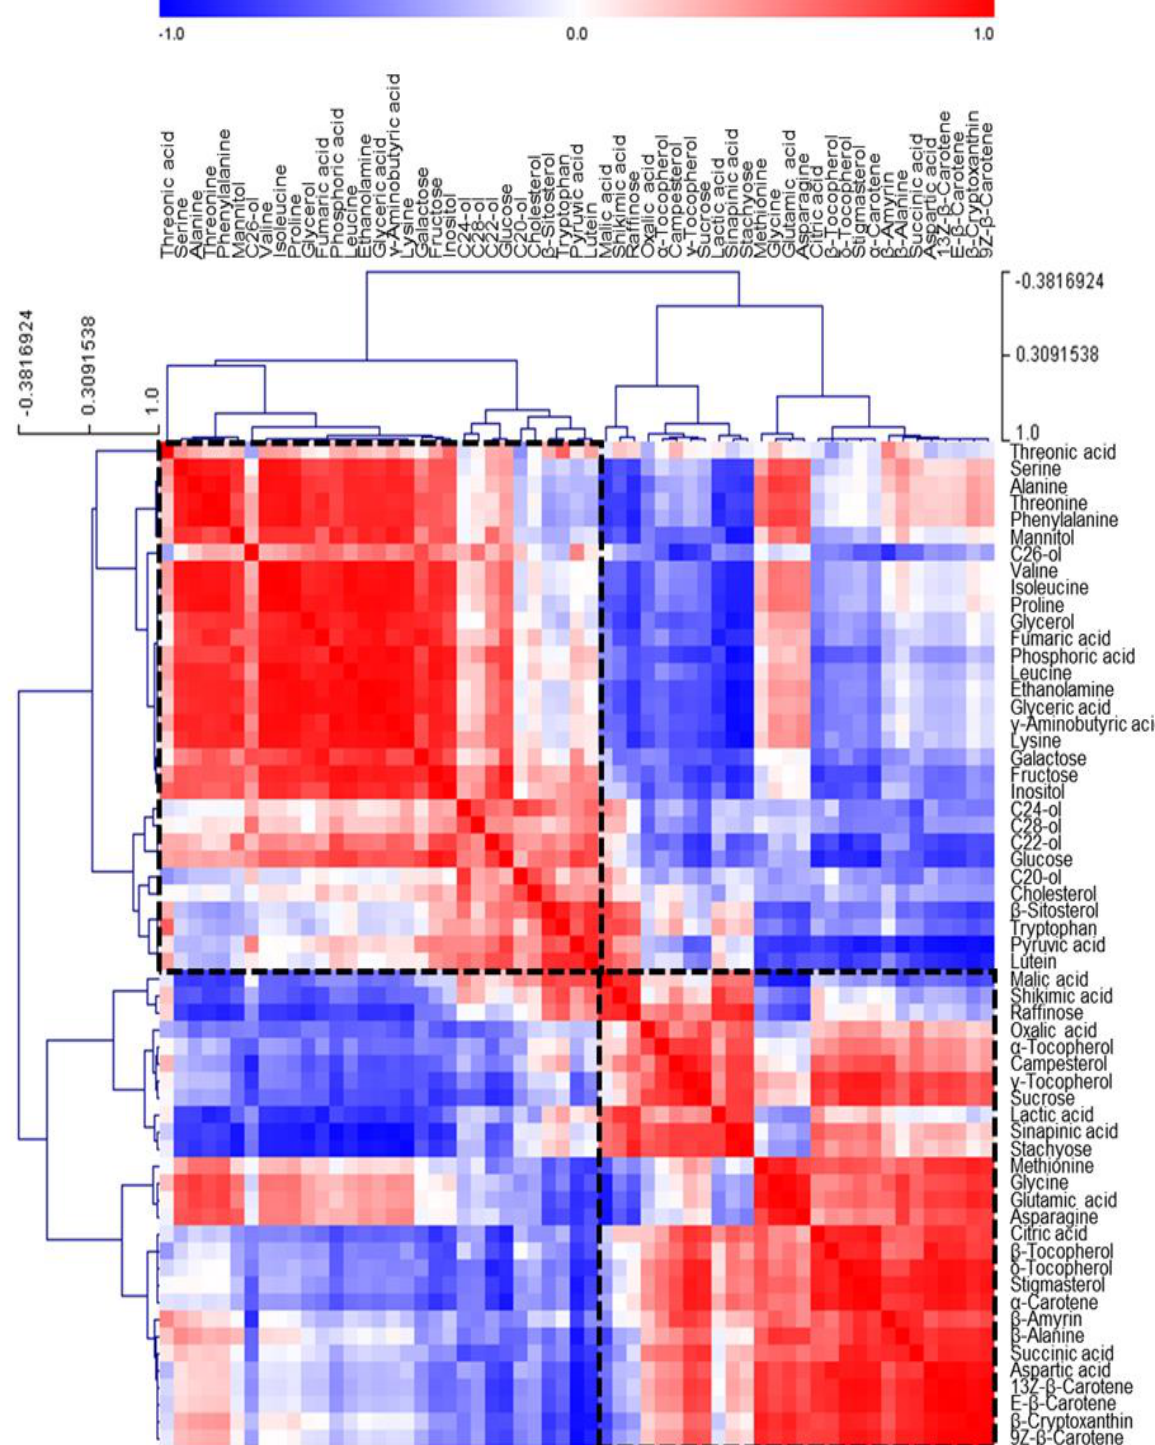
Figure 2. Correlation matrix and cluster analysis of data for 59 metabolites of soybean seeds. Each square indicates the Pearson’s correlation coefficient of a pair of compounds, and the value of the correlation coefficient is represented by the intensity of blue or red colors, as indicated on the color scale. Hierarchical clusters are presented as a cluster tree. C20-ol,